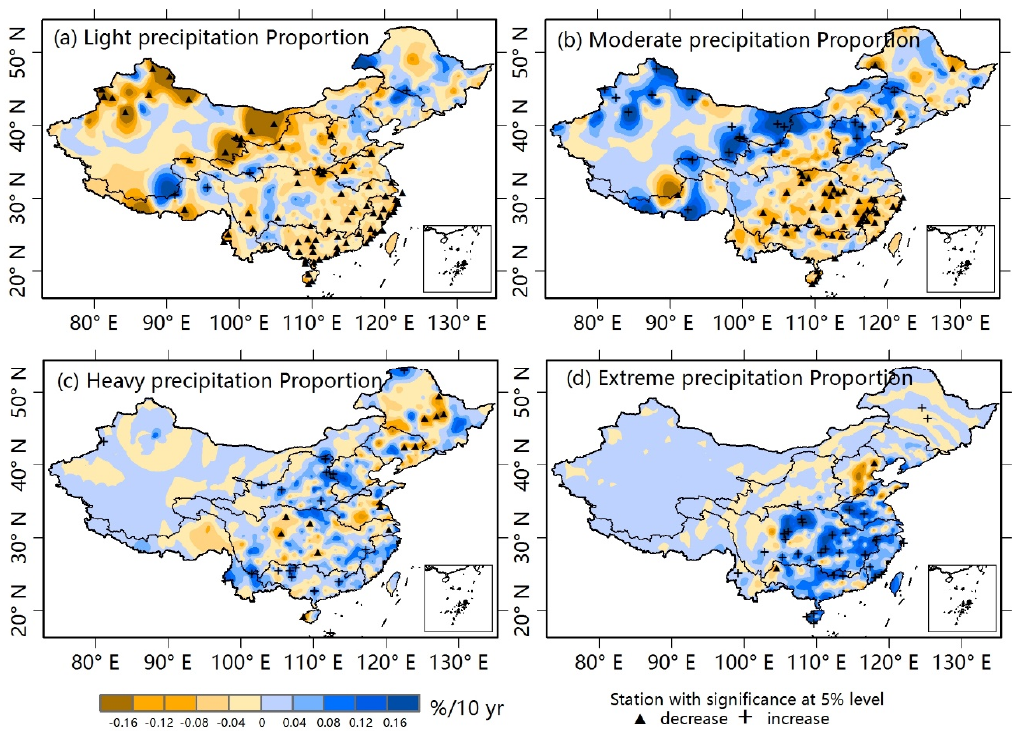
Figure 4. Trends in the proportion of each precipitation category relative to annual precipitation for 1960–2013. ( a ) Light precipitation; ( b ) moderate precipitation; ( c ) heavy precipitation; and ( d ) extreme precipitation.